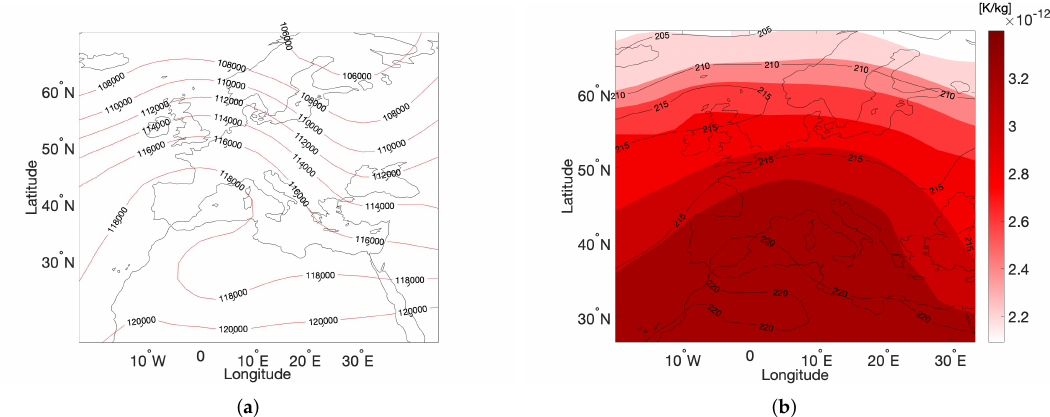
Figure 8. Meteorological parameters and O 3 aCCFs at 250 hPa on 1 February 2016: ( a ) geopotential (isolines, m 2 /s 2 ), ( b ) temperature (isolines, K) and O 3 aCCFs (colour contours, K/kg(NO 2 )).